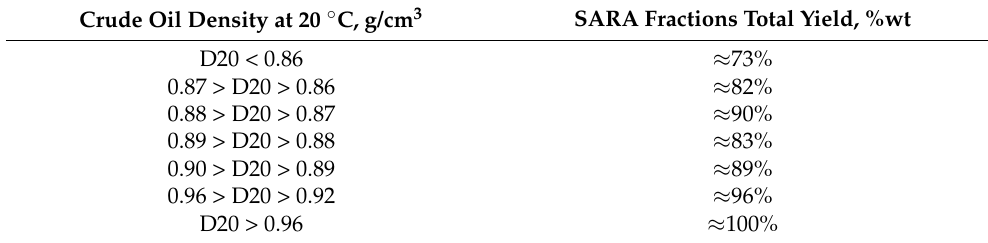
Table 7. Variation of SARA fractions yields obtained during the use of HPLC method with crude oil density at 20 ◦ C [134]. Crude Oil Density at 20 ◦ C, g/cm 3 SARA Fractions Total Yield, %wt D20 <